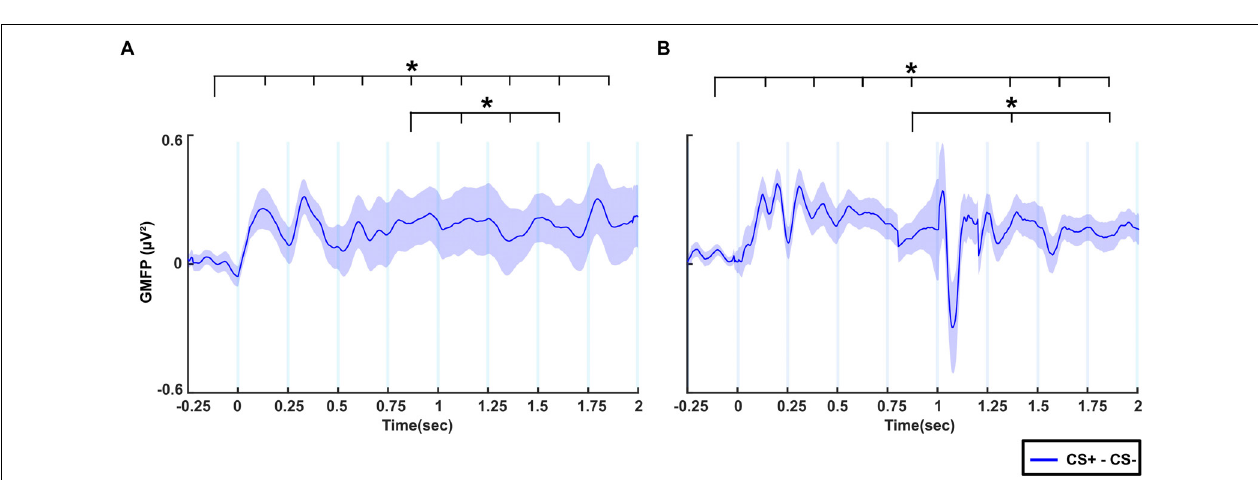
FIGURE 4 | The difference of global mean field power (GMFP) between CS+ and CS– for (A) no-TMS experiment and (B) TMS experiment. The curve shadings are mean ± standard error of the mean. The asterisk ( ∗ ) denotes significant differences after correcting for multiple comparisons ( p < 0.05, Bonferroni